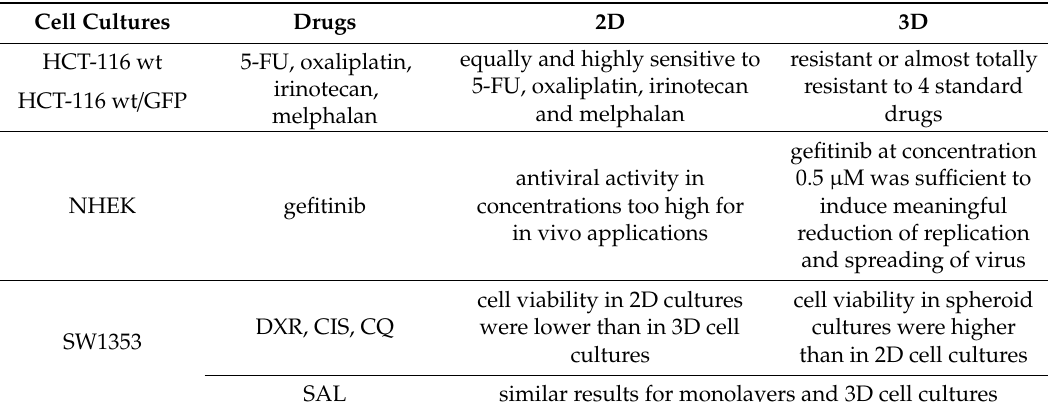
Table 2. Comparison of drug testing results on 2D and 3D